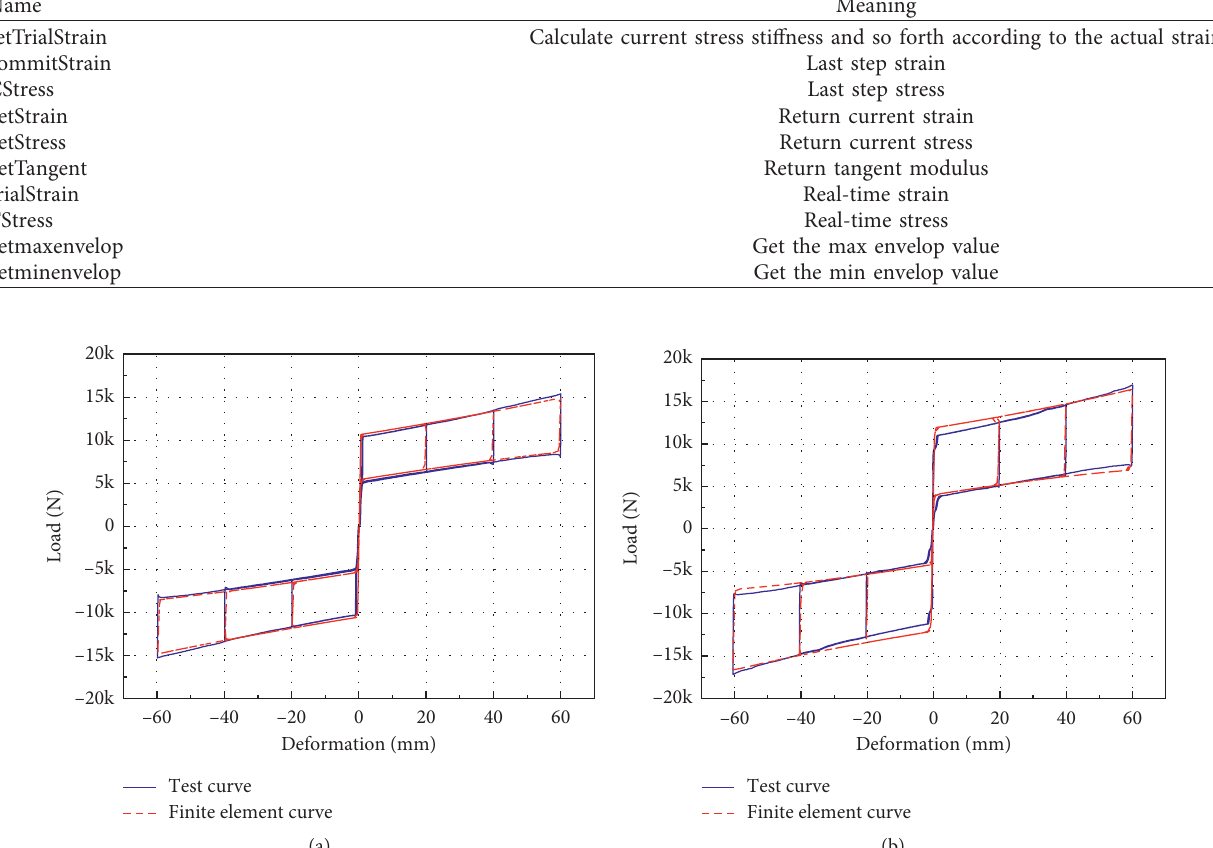
Figure 12: Hysteresis curves of test and finite element (SCVF brace with spring S1). (a) 5 mm deflection of the friction plate. (b) 7.5mm deflection of the friction plate.